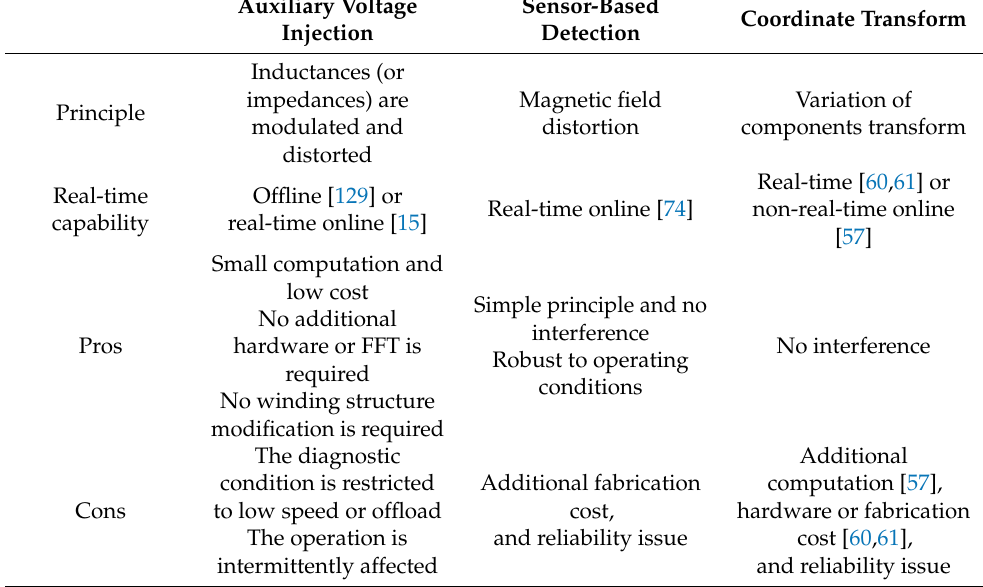
Table 3. Comparison of predominant methods in distinguishing eccentricity and